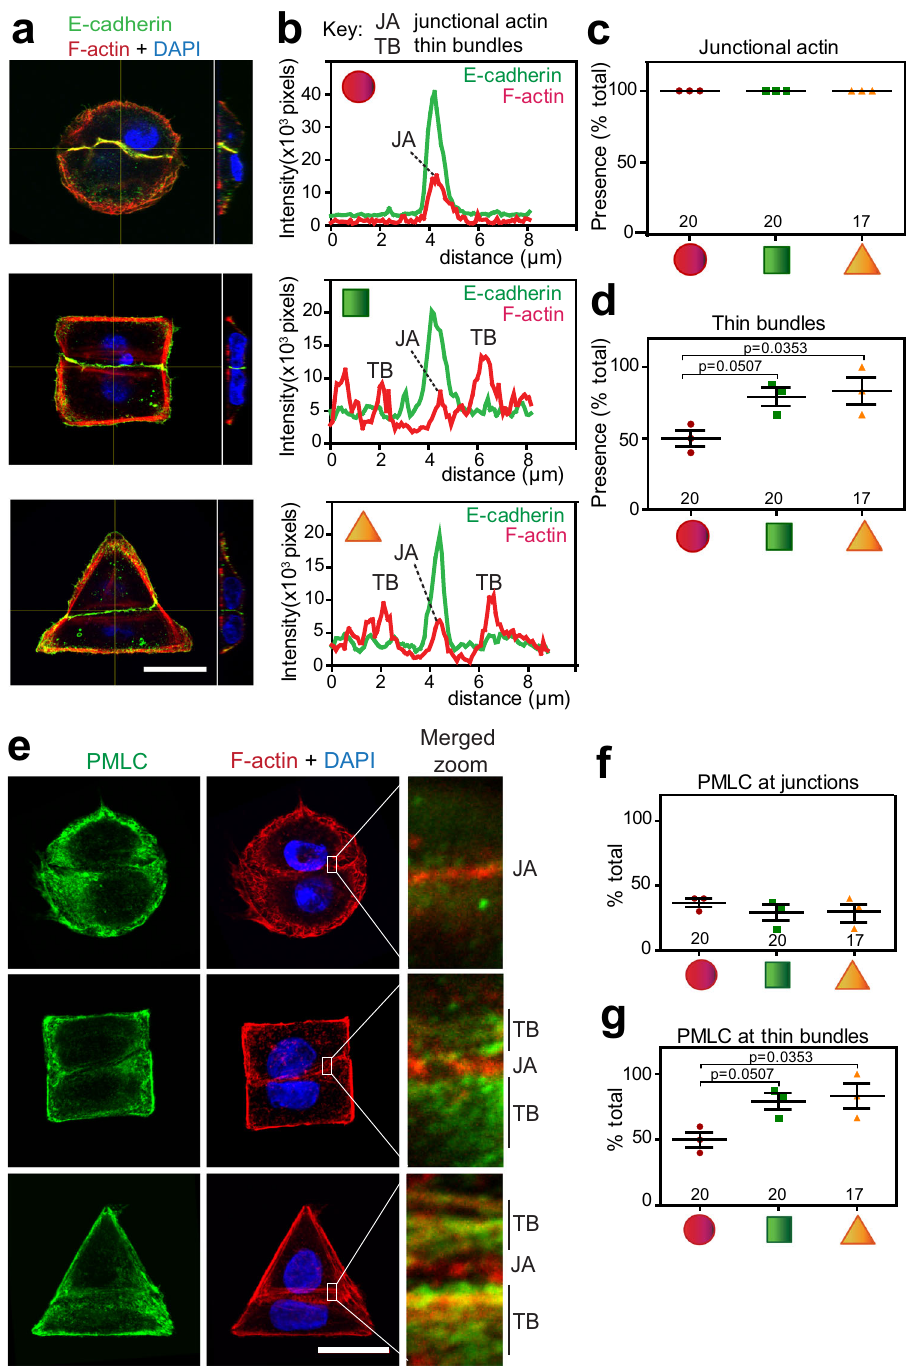
Fig. 5 | Geometric constraints modulate the optimal organization of the epithelial cytoskeleton. Keratinocytes grown on different geometries were fi xed andstainedforF-actin,nucleus,andE-cadherin( a )orphosphorylatedmyosinlight chain (PMLC, e ). b Representative line scan perpendicular to and at the middle of each junctionwasdrawn and theintensity pro fi leofE-cadherin (green) and F-actin (red) was obtained. Peaks of high intensity show the junctional actin (JA) co- localizing with E-cadherin. Parallel, adjacent thin bundles (TB) are clearly seen in squaredand triangular cellpairs. c and d Percentage of micropatternsshowingthe presence of junctional actin ( c ) or thin bundles ( d ) across different geometries. e Representative images show the distribution of contractile fi laments (PMLC,